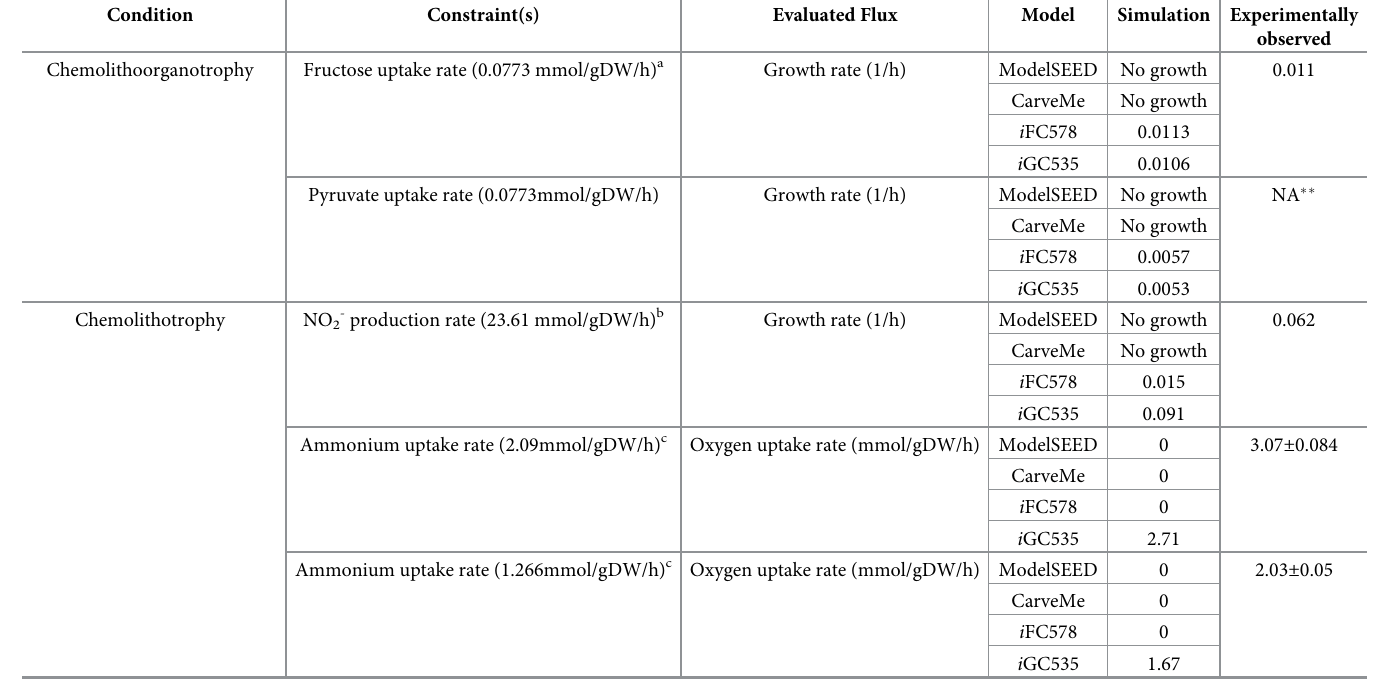
Table 2. Comparative table of simulations performed under different growth conditions of the Ne genome-scale model ( i GC535) and other models. Condition Constraint(s) Evaluated Flux